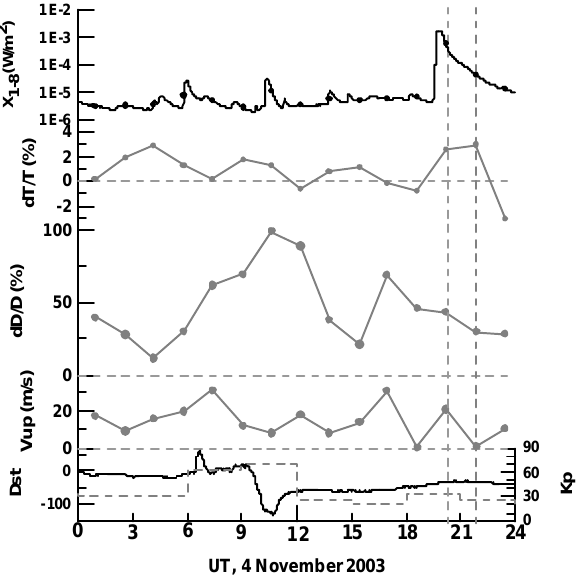
Fig. 7. Strongly perturbed topside ionosphere at sunlit hemisphere before the X28 solar flare at ~2100 UT on November 4, 2003 (from top to bottom): solar X-ray emission with wavelengths 1-8 Å; relative changes of the ion temperature dT/T and density dD/D; vertical ion drift velocity Vup; geomagnetic indices Kp (dashed histogram, right axis) and 1-min Dst (solid line). Circles indicate values of the parameters, which are averaged within daytime passes of the ROCSAT-1. Vertical dashed lines depict the interval around the solar flare time.